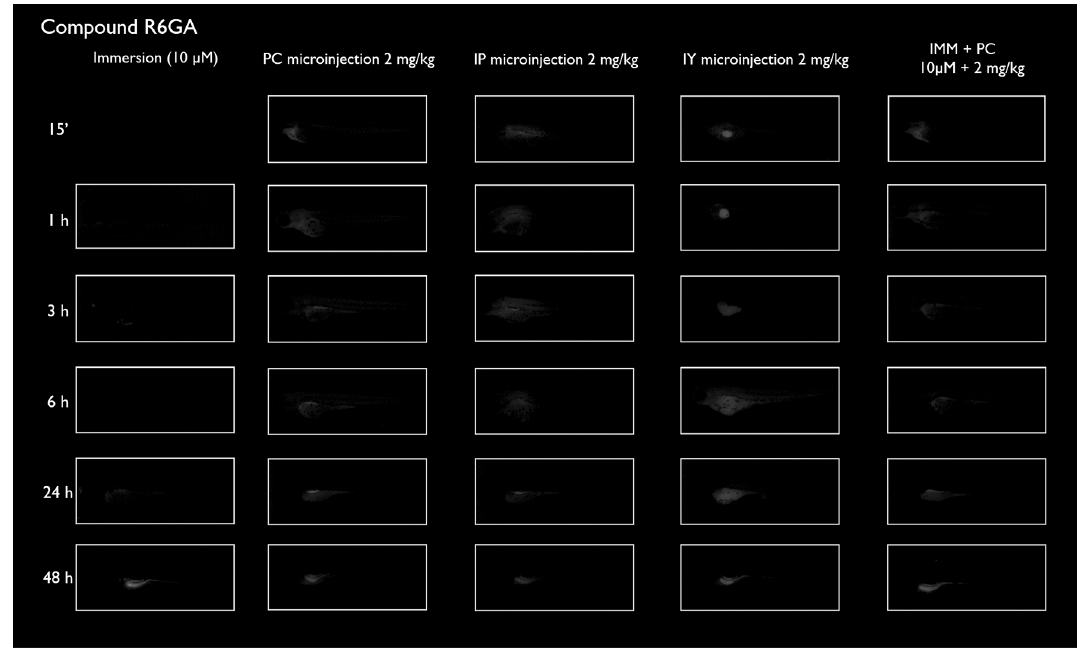
Figure 6. Representative pictures of the spatiotemporal distribution of the fluorescent compound R6GA. The eleuthero-embryos were exposed to the dye by immersion (10 µM) or microinjection (2 mg/kg) in the pericardial cavity (PC), intraperitoneally (IP) and in the yolk sac (IY), or by a combination of immersion and PC microinjection, for 48 h starting from 3 dpf. Selected images arranged in MS PowerPoint and GIMP (version 2.10.24 https:// www. gimp. org/ 2021) Software.